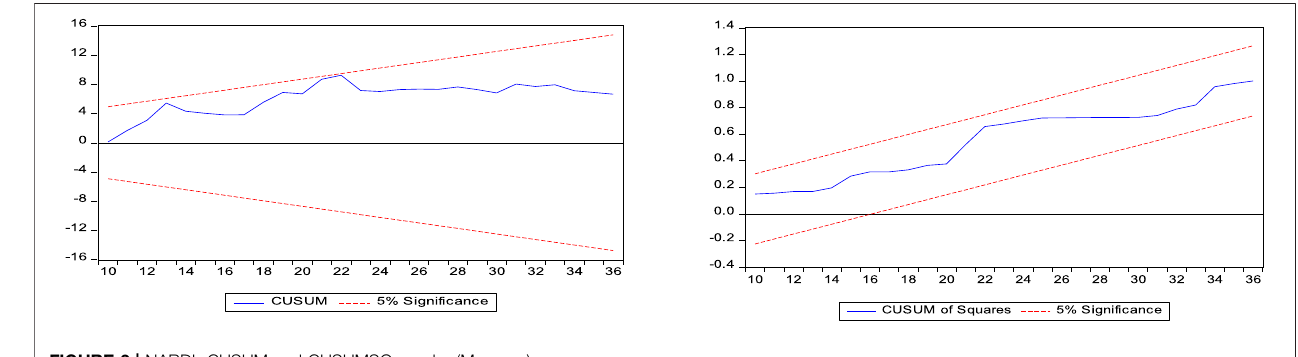
FIGURE 3 | NARDL CUSUM and CUSUMSQ graphs (Morocco).